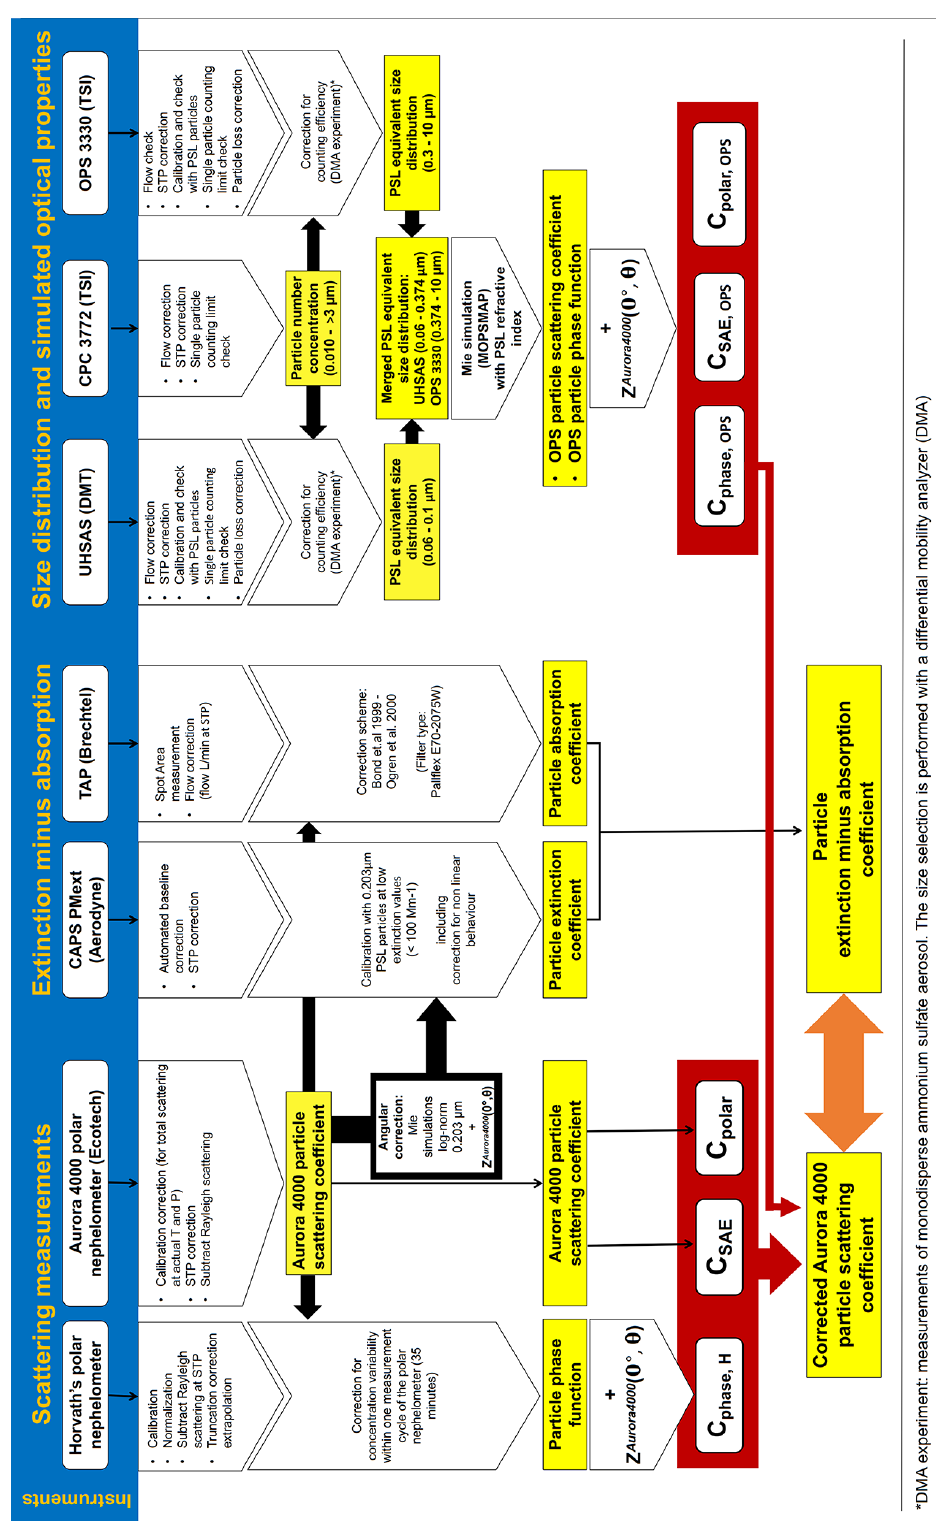
Figure 2. Flow chart of the data evaluation for the laboratory closure experiment. All instruments involved in the laboratory closure experi- ment are on the top bar. The descending arrows illustrate the data elaboration to obtain from raw data the relevant quantities (in the yellow boxes) and the different angular corrections (in the red boxes). Thick black arrows indicate when data are used in the data processing of a different